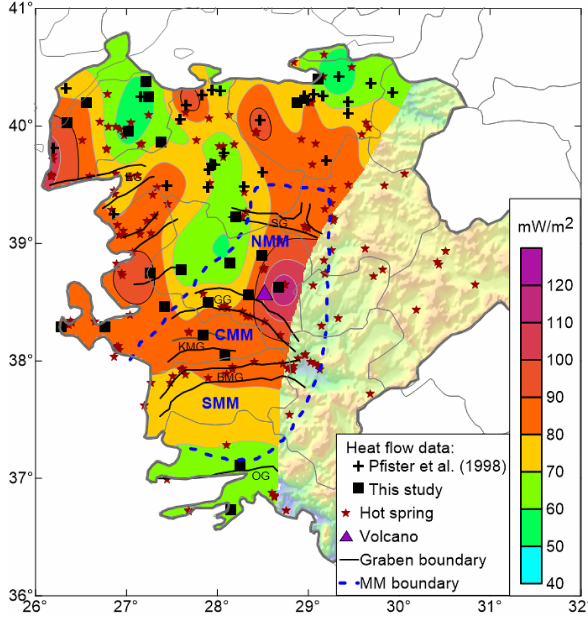
Figure 4. The preliminary heat flow map of the region using the results of this study (class A/B/C data in Table 2), and of Pfis- ter et al. (1998). Blue lines outline the boundary of the Menderes Massif. The blue triangle indicates the location of the Kula volcanic